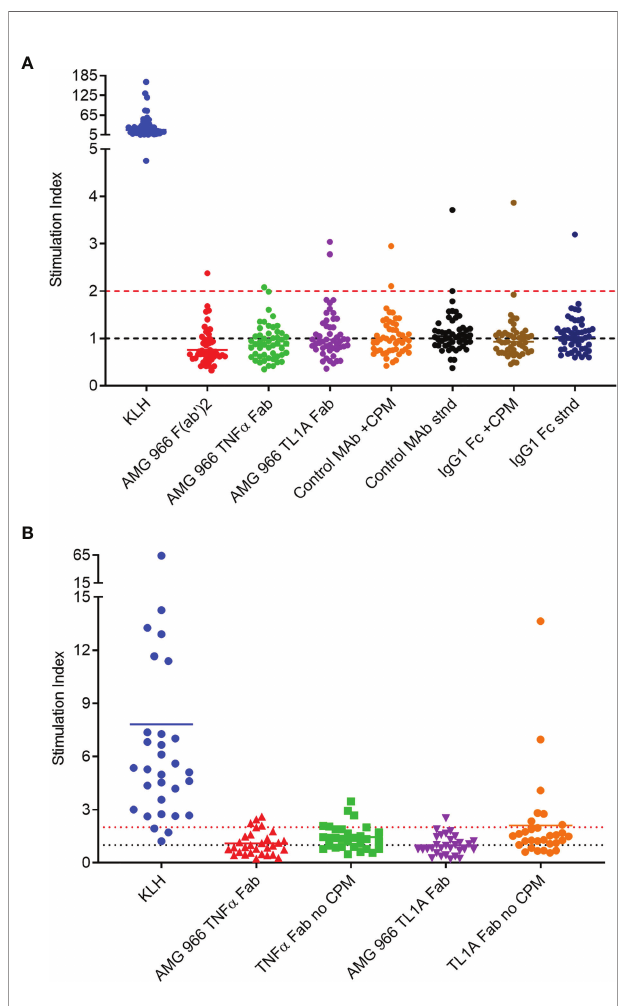
FIGURE 1 | In vitro T cell assays did not reveal sequence-based risk of immunogenicity for AMG 966. T cell assays were performed with naïve donors representative of global HLA allele frequencies. Results are shown as stimulation index, or test protein divided by the baseline condition (media alone). (A) PBMC from 50 donors were stimulated with each test protein for 6 days prior to assessment of CD4 T cell proliferation by fl ow cytometry. A control monoclonal antibody and an IgG1 Fc domain were tested both with charge pair mutations (CPM) and without (stnd). (B) Monocytes from 30 PBMC donors were differentiated into dendritic cells, loaded with test protein, and matured. Autologous CD4 T cells were isolated and co-cultured with mature dendritic cells presenting test protein agretopes for 6 days prior to assessment of CD4 T cell proliferation by fl ow cytometry. Fab domains were tested with and without